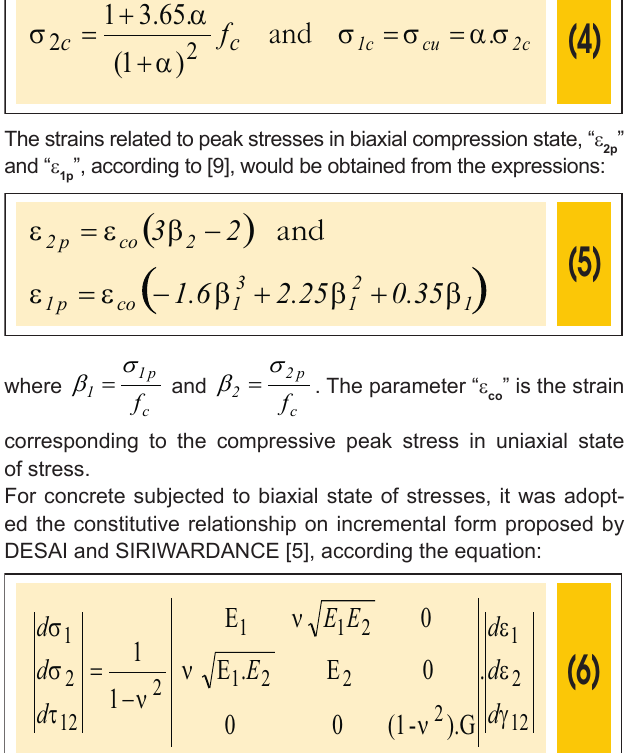
Figure 3 – Finite Elements: a) Bars